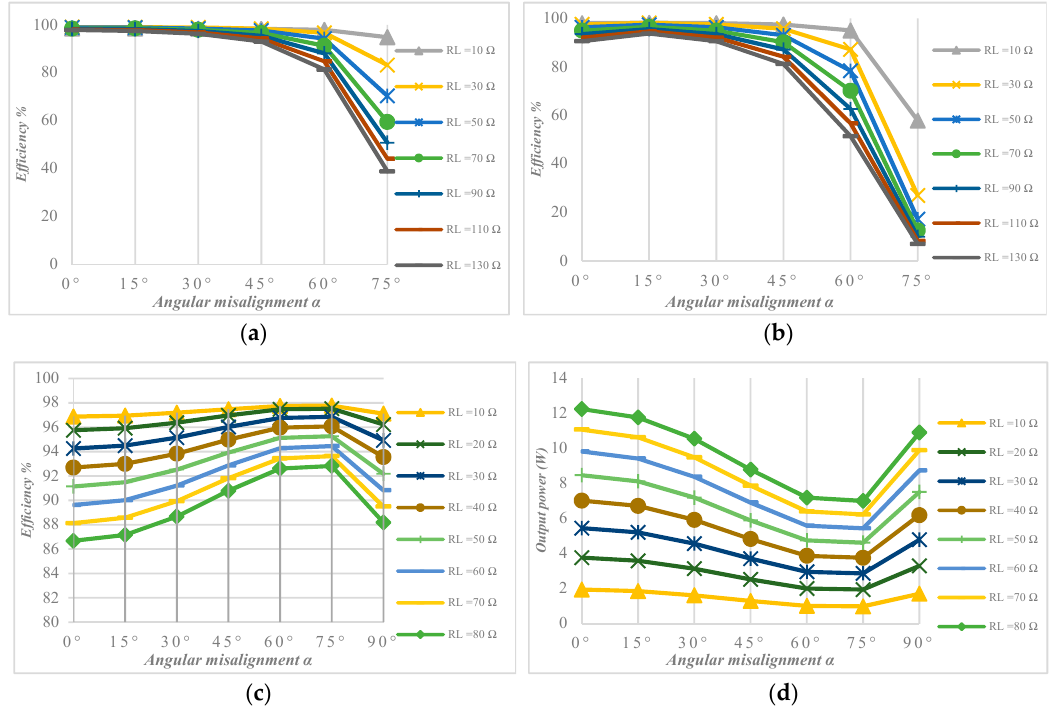
Figure 11. The relationship between efficiency, load, and angular misalignment: ( a ) equator windings; ( b ) hemisphere windings; ( c ) optimal model; ( d ) output power of the optimal model.